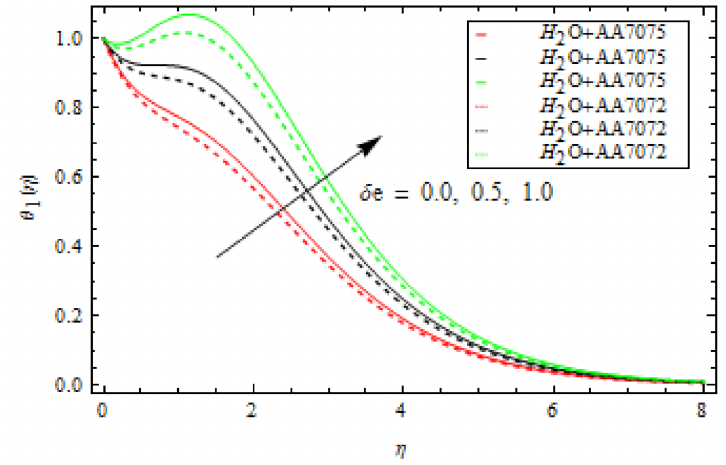
Figure 11. Influence of thermal relaxation parameter δ e on temperature profile.